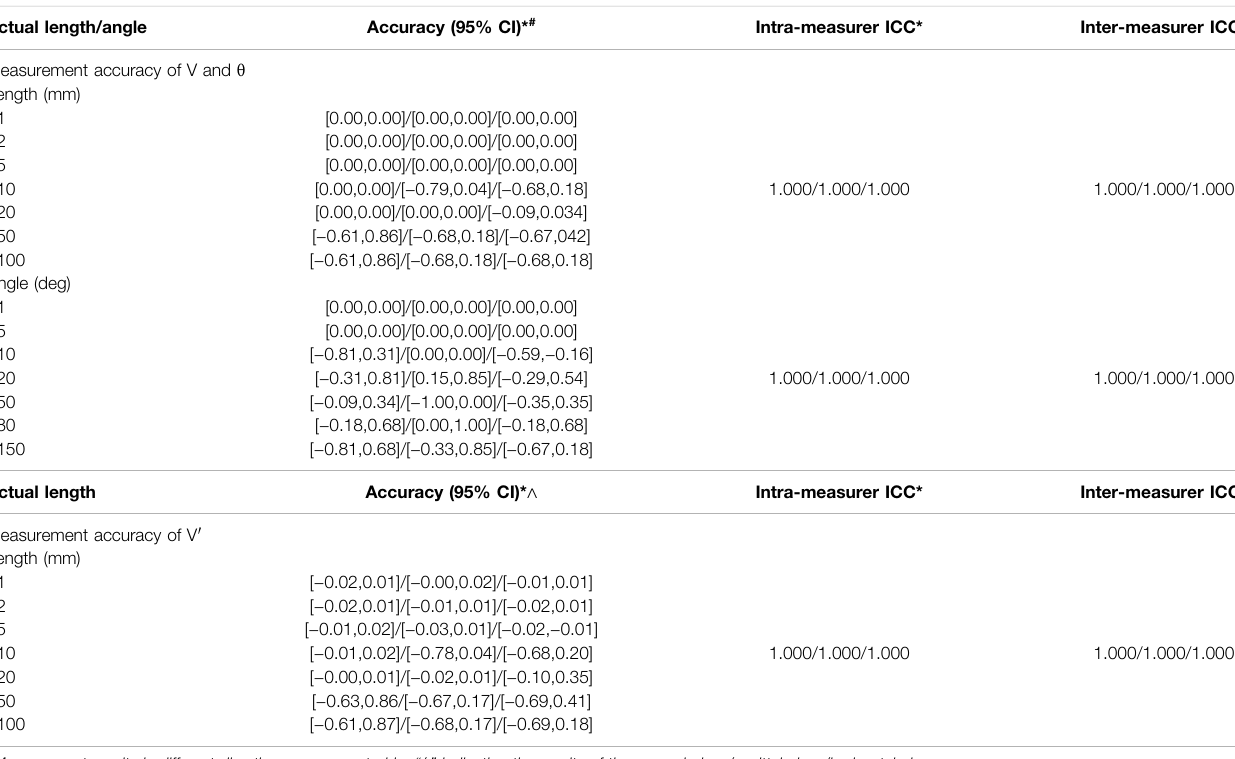
TABLE 1 | All angles/lengths tested in the experiment have a measurement accuracy of < 1 ° /1 mm; see text for details. Actual